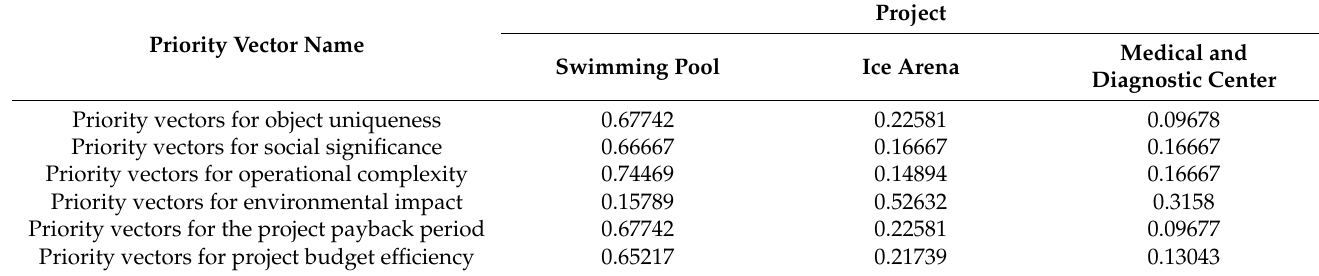
Table 6. Priority vector values.